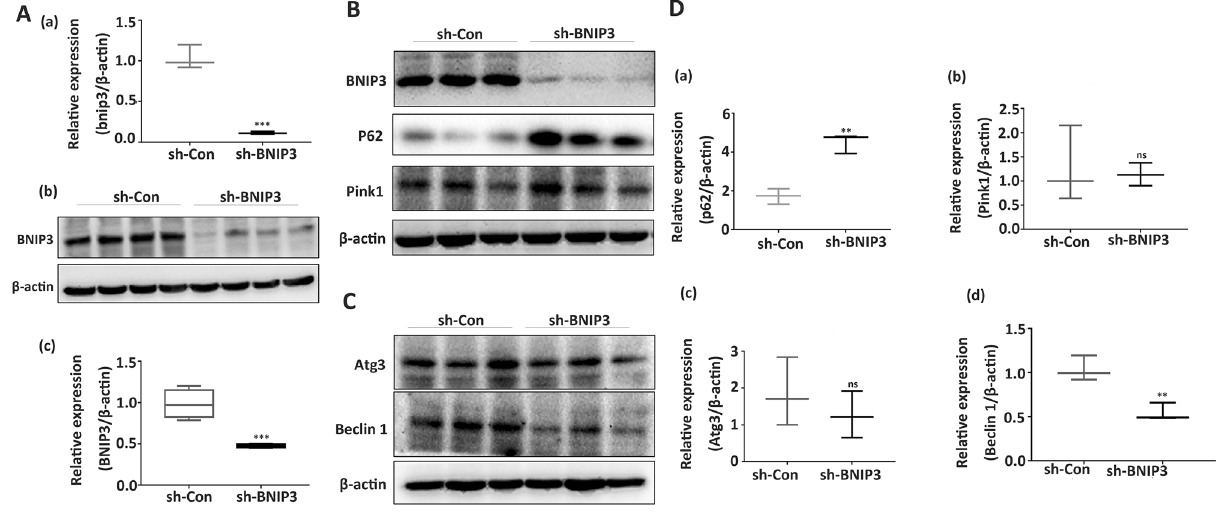
Figure 2. The effects of BNIP3 downregulation on the expression of Beclin-1, P62, Atg3, and Pink1. ( A ) Results from qRT-PCR and Western blot indicated that sh-BNIP3 transfection showed high-efficiency BNIP3 gene silencing (n = 3 per group). ( B , D ) Representative Western blot bands of BNIP3, P62, and Pink1 in HTR-8/SVneo cells after sh-RNA transfection. β-Actin was used as a control (n = 3 per group). ( C , D ) Representative western blot bands of Beclin-1 and ATG3 in HTR-8/SVneo cells after sh-RNA transfection (n = 3 per group). β-Actin was used as a control. ns: non-significant, * p -value < 0.05, ** p -value < 0.01, *** p -value < 0.001. Full-length blots are presented in Supplementary Figure